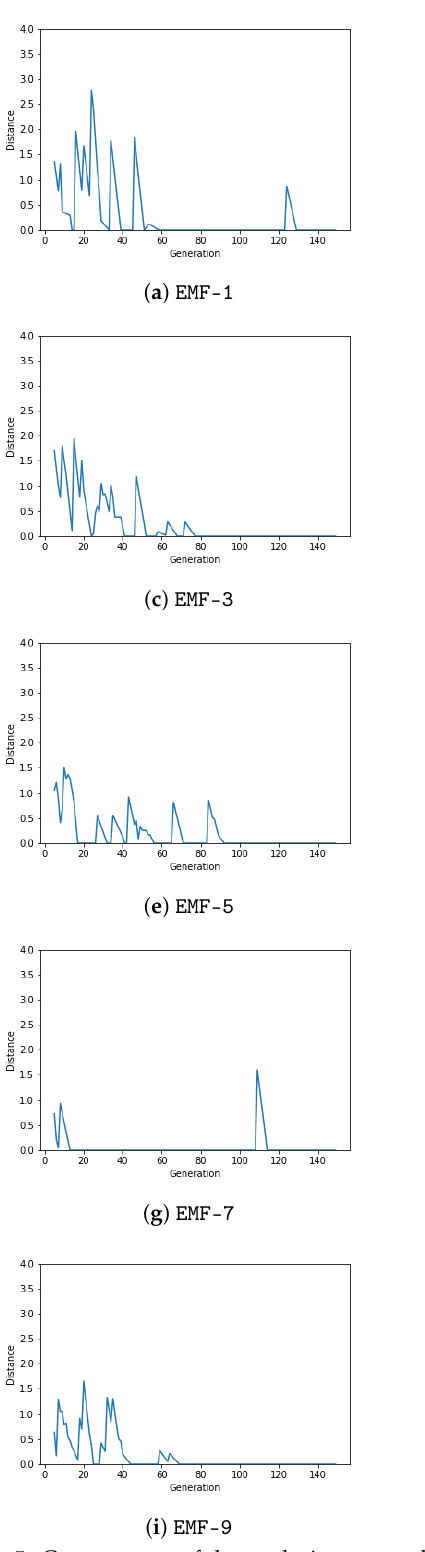
Figure 5. Convergence of the evolutionary method on the MovieLens dataset. The plots show the moving average distance D 5 ( n ) with window width W = 5 and p = 2 during the 150 generations of the 10